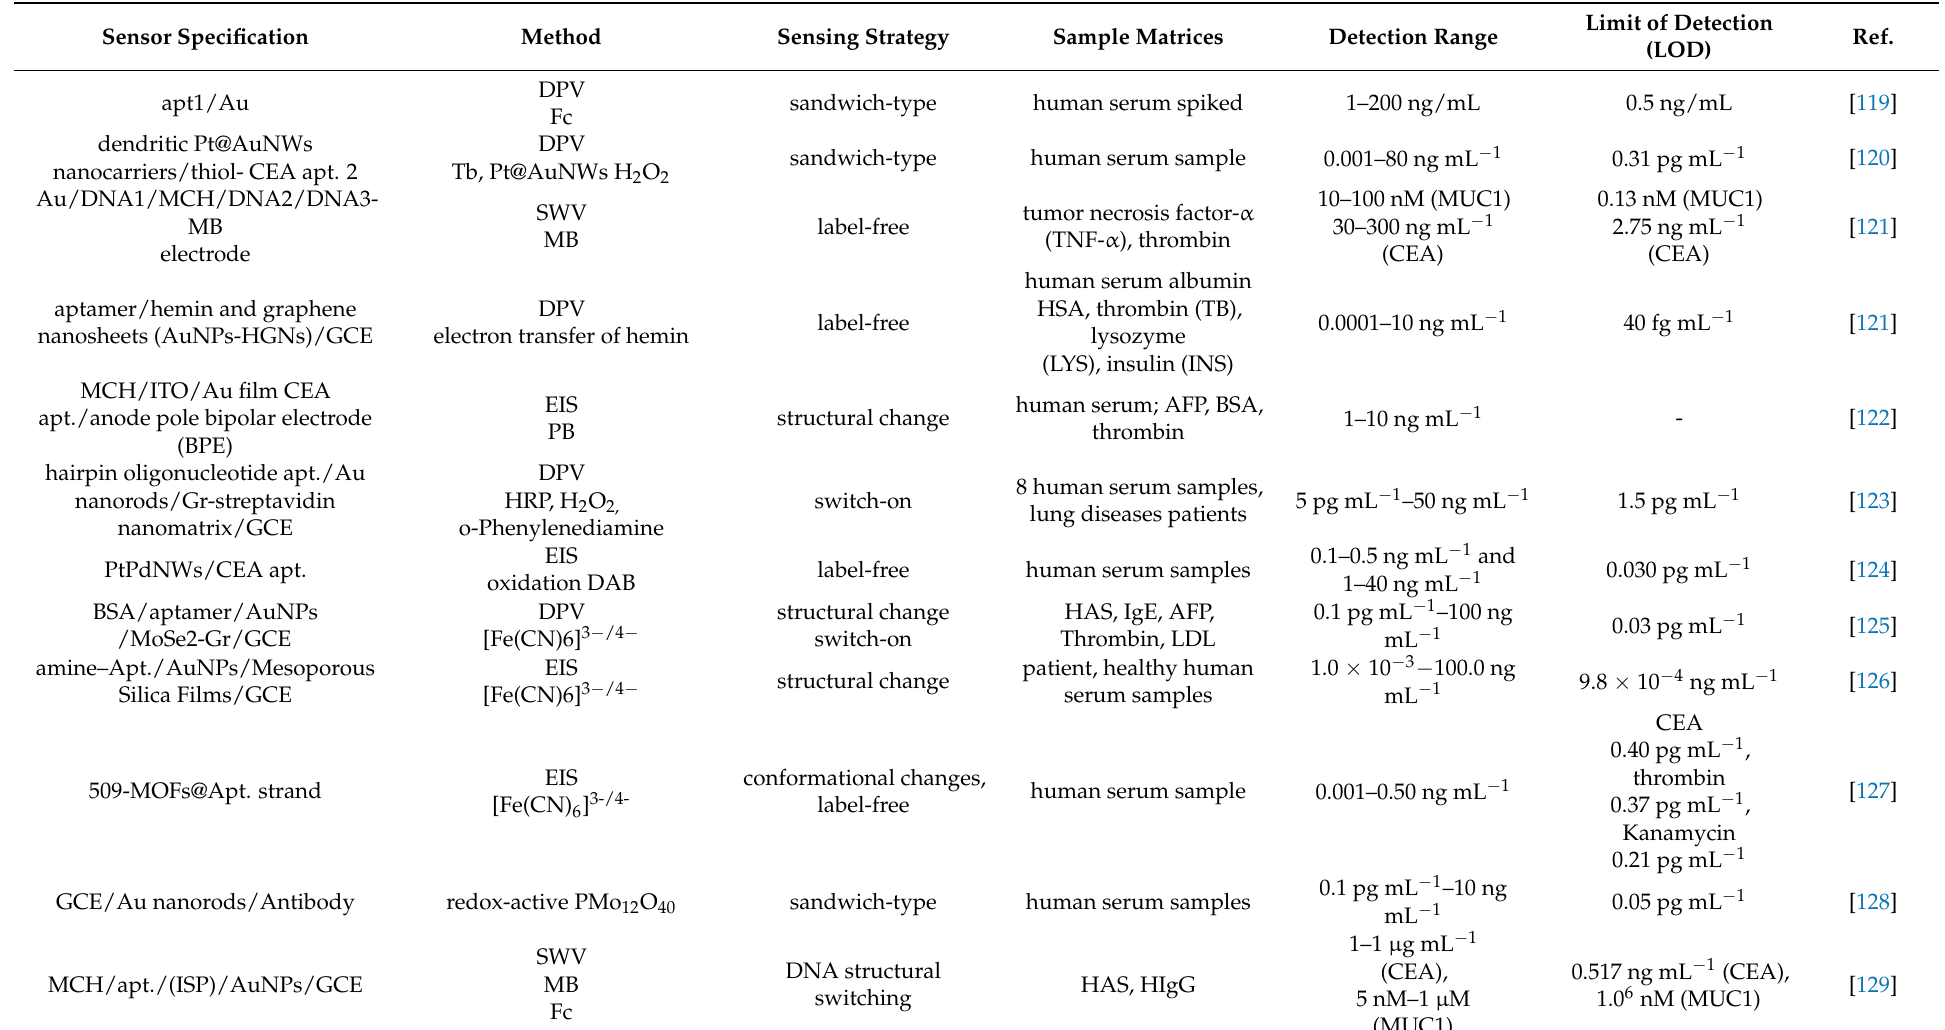
Table 5. Specifications and electrochemical performance of aptasensors for carcinoembryonic antigen